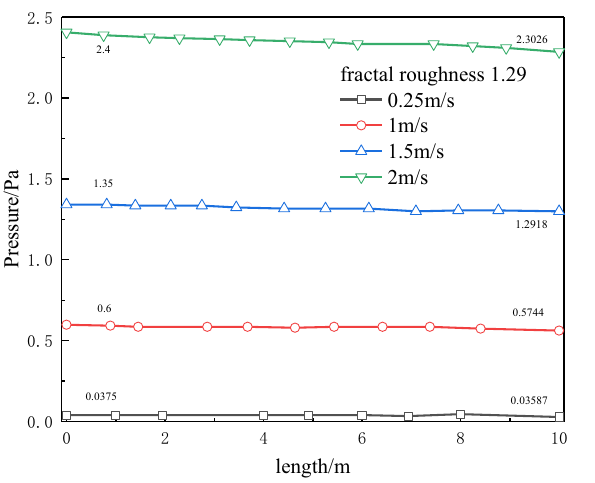
Figure 9. Average pressure drop in roadway section.